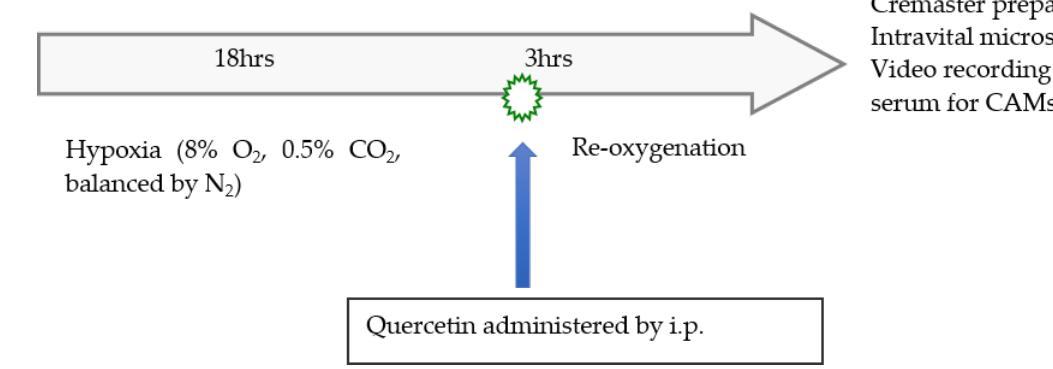
Figure 1. Schematic representation of experimental design.